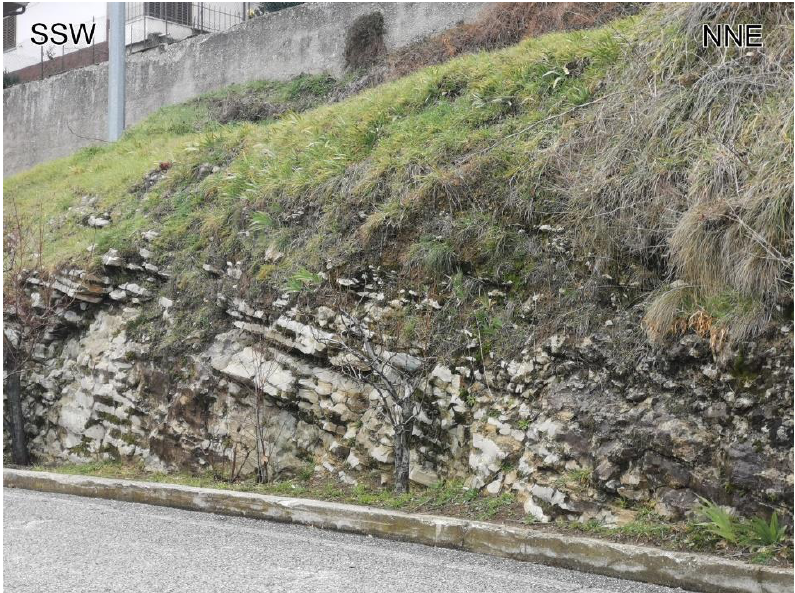
Figure 6. Arenaceous-conglomeratic bedrock outcropping on the eastern side of the relief of Mount